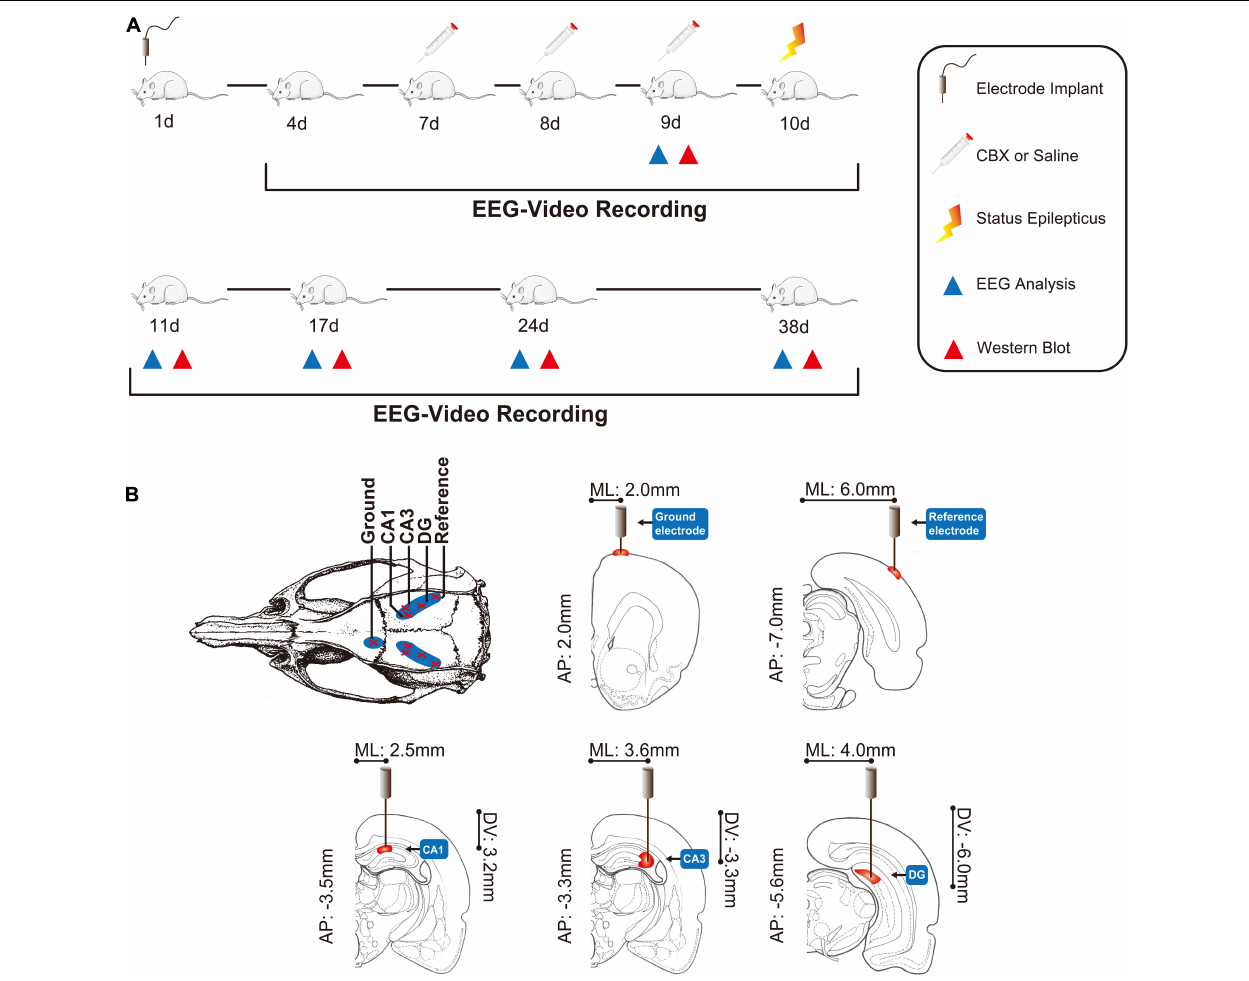
FIGURE 1 | Comprehensive modeling of chronic epilepsy. (A) Schematic representation of the overall protocol and various analyses performed in chronic epileptic rats. (B) The positions of the EEG recording electrodes. CBX, carbenoxolone; AP, anteroposterior; ML, mediolateral; DV, dorsoventral.